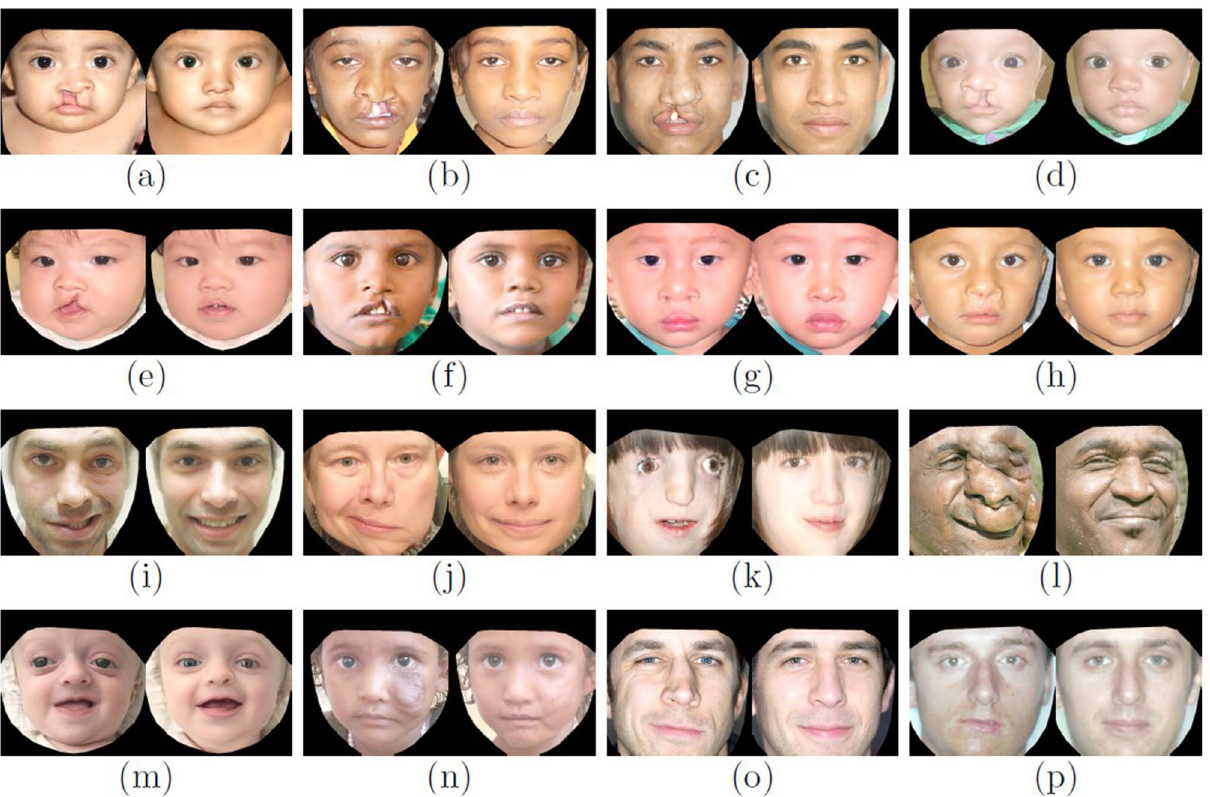
Figure 5. Raw-normalized image pairs for a variety of different clinical diagnostic categories ( a – d ) complete unilateral cleft lip; ( e , f ) incomplete unilateral cleft lip; ( g , h ) reconstructed bilateral cleft lip; ( i , j ) unilateral facial palsy; ( k ) Treacher Collins syndrome; ( l ) neurofibromatosis; ( m ) craniofacial dysostosis; ( n ) vascular anomaly; ( o ) nasal deformity; ( p ) jaw asymmetry]. Image references: ( a ) 46 , d 51 , ( f ) 52 , ( h ) 53 , i 54 , ( n ) 55 , ( o ) 56 , p 57 . All remaining images are duplicates or transformations created by the study